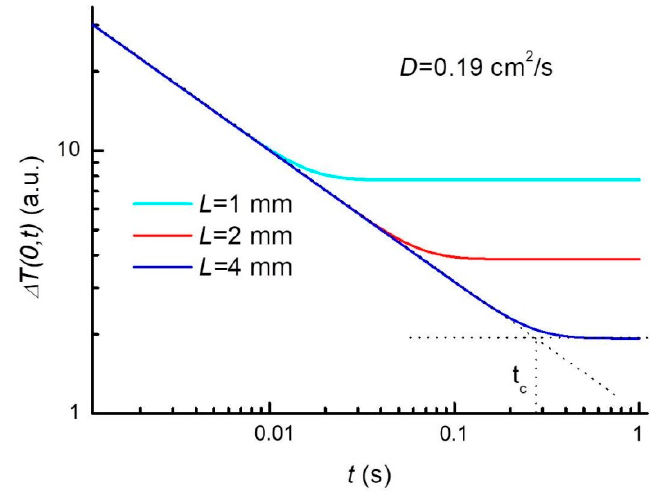
Figure 1. Double logarithmic plot of the decay of the surface temperature with time calculated for D = 0.19 cm 2 /s and for the thickness ( L ) values reported in the inset.